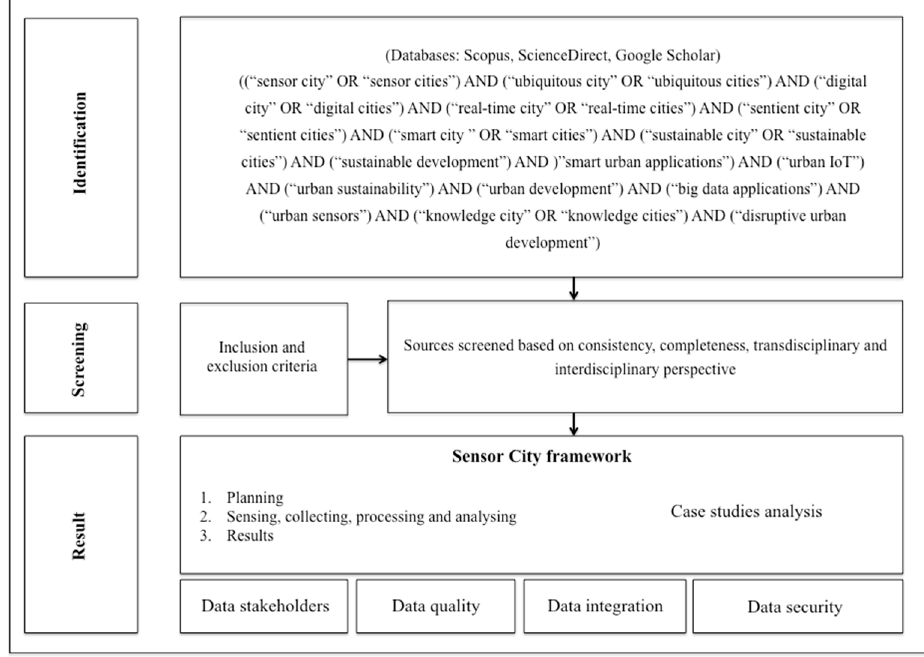
Figure 1. Methodological approach adopted (source: authors).